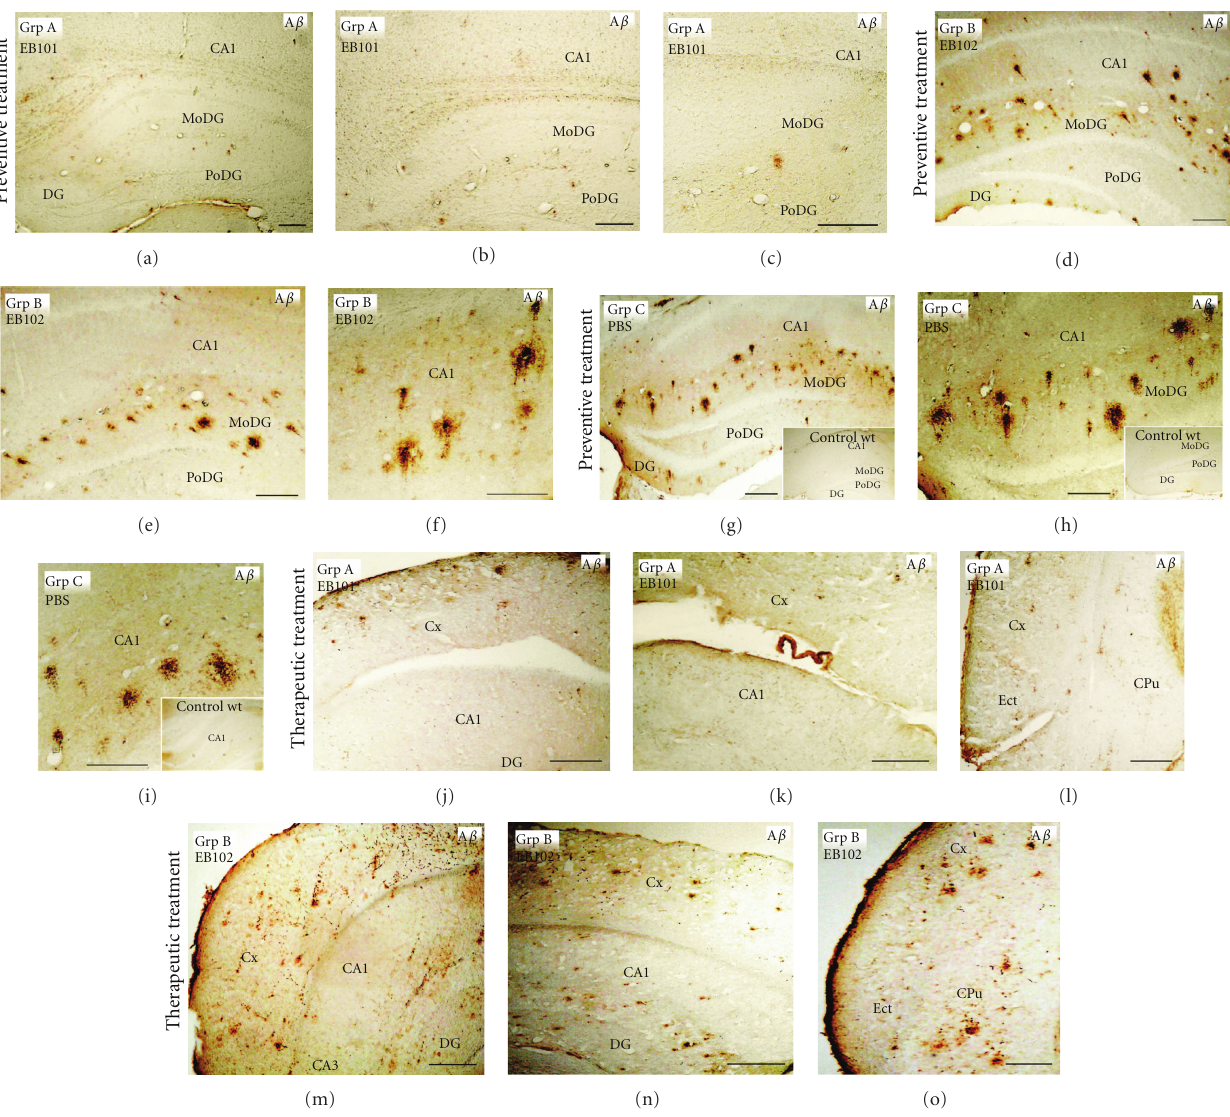
Figure 1: E ff ect of EB101 vaccine on beta amyloid (A β ) deposits in the brains of B6C3F1/J mice. Comparative photomicrographs of A β immunoreactivity were taken in the hippocampus ((a)–(k), (m), (n)) and cortical ((l), (o)) brain regions of transgenic mice treated with the vaccine (Grp A) before A β plaques develop preventive treatment ((a)–(i)) and after the A β plaques developed therapeutic treatment ((j)–(o)). Preventive Treatment : Transverse brain sections of 11-month-old mice show almost complete absence of A β deposits in the dentate gyrus ((a)–(c)) and hippocampal subregion CA1 following EB101 vaccine immunization (group A), contrasting sharply with the numerous A β immunoreactive plaques in the corresponding mouse brain sections treated with EB102 (group B in (d)–(f)) or PBS (group C in (g)–(i)). Immunoreactive A β in the brain sections of wild-type mice is absent (inserts in (g)–(i)). Therapeutic Treatment : Transverse brain sections of 18-month-old mice are shown in (j)–(o). Treatment with EB101 almost completely abolished A β load in the retrosplenial cortex/hippocampal subregion CA1 ((j)–(k)) and ectorhinal cortex (l) compared to the same areas of mice treated with EB102 ((m)–(o)), as determined by number of plaques and staining intensity area. Scale bar: 100 μ